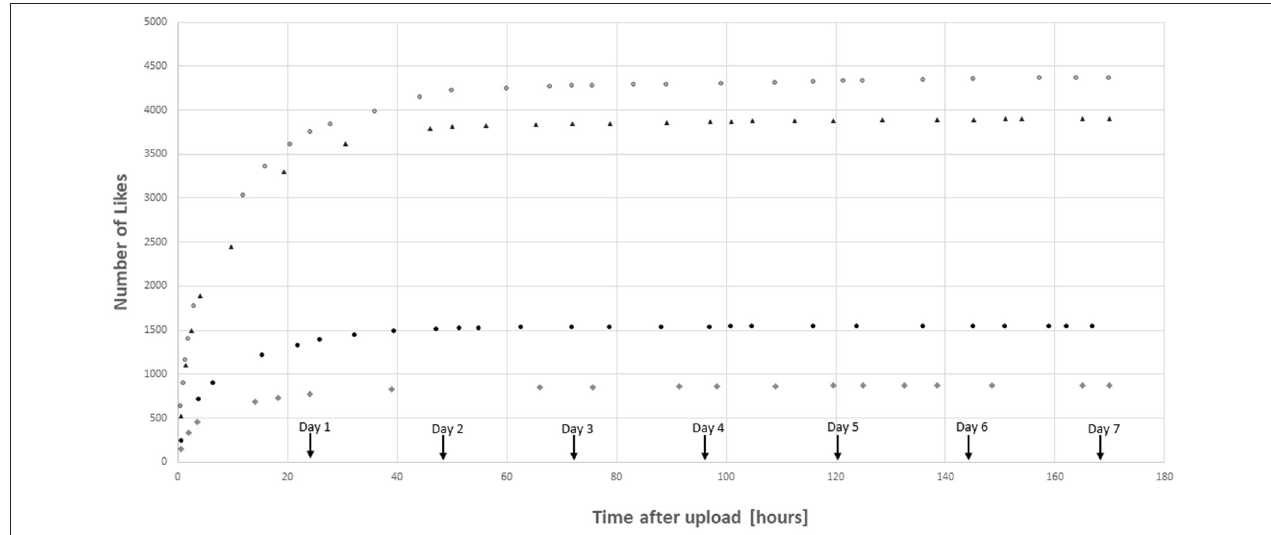
FIGURE 2 | Examples from four posts on different Instagram accounts showing how the number of Likes typically emerges over time.